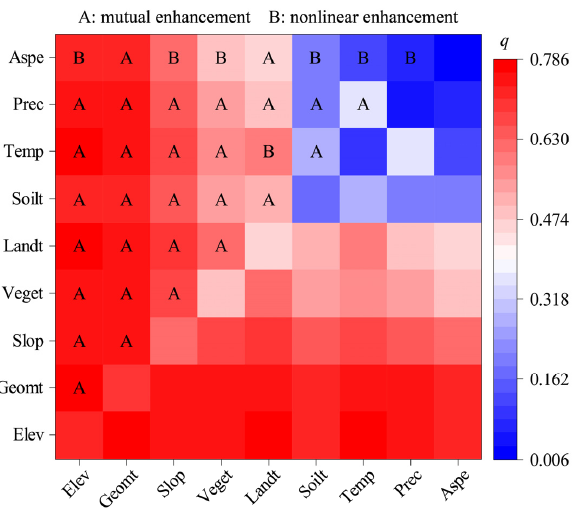
Figure 12. Interactions between driving factors.